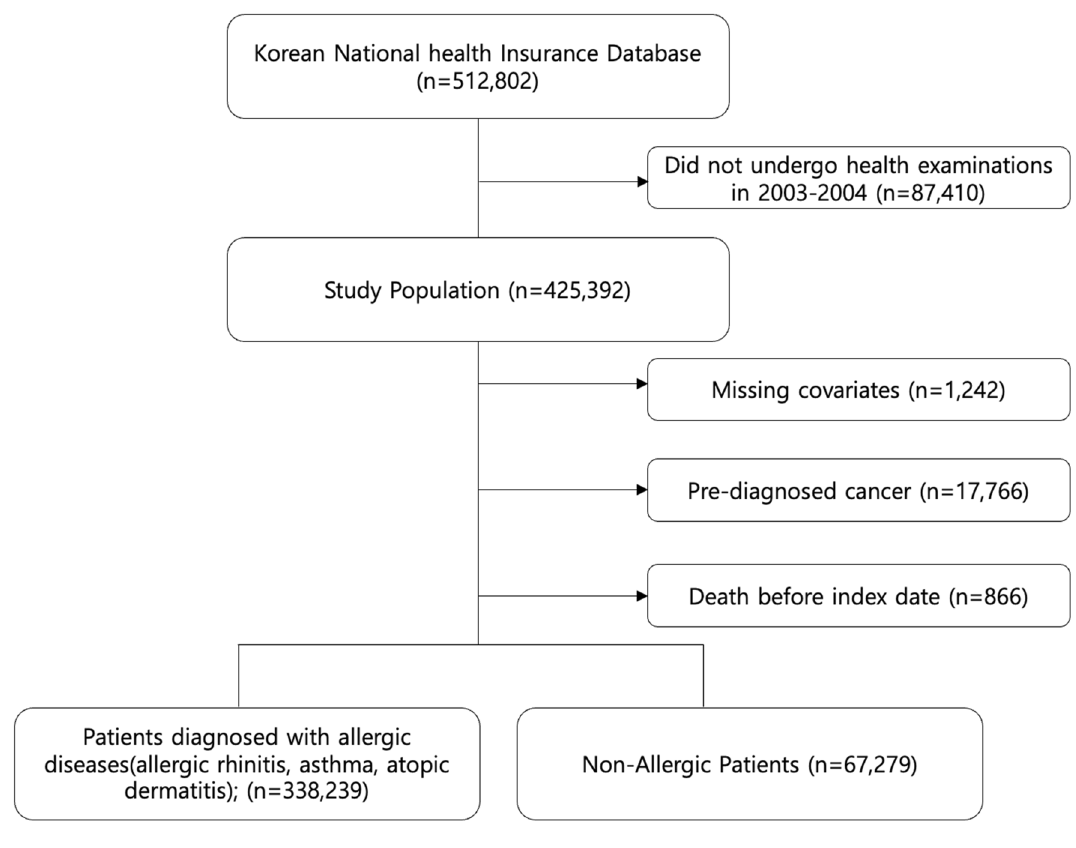
Figure 1. Flow diagram of the study